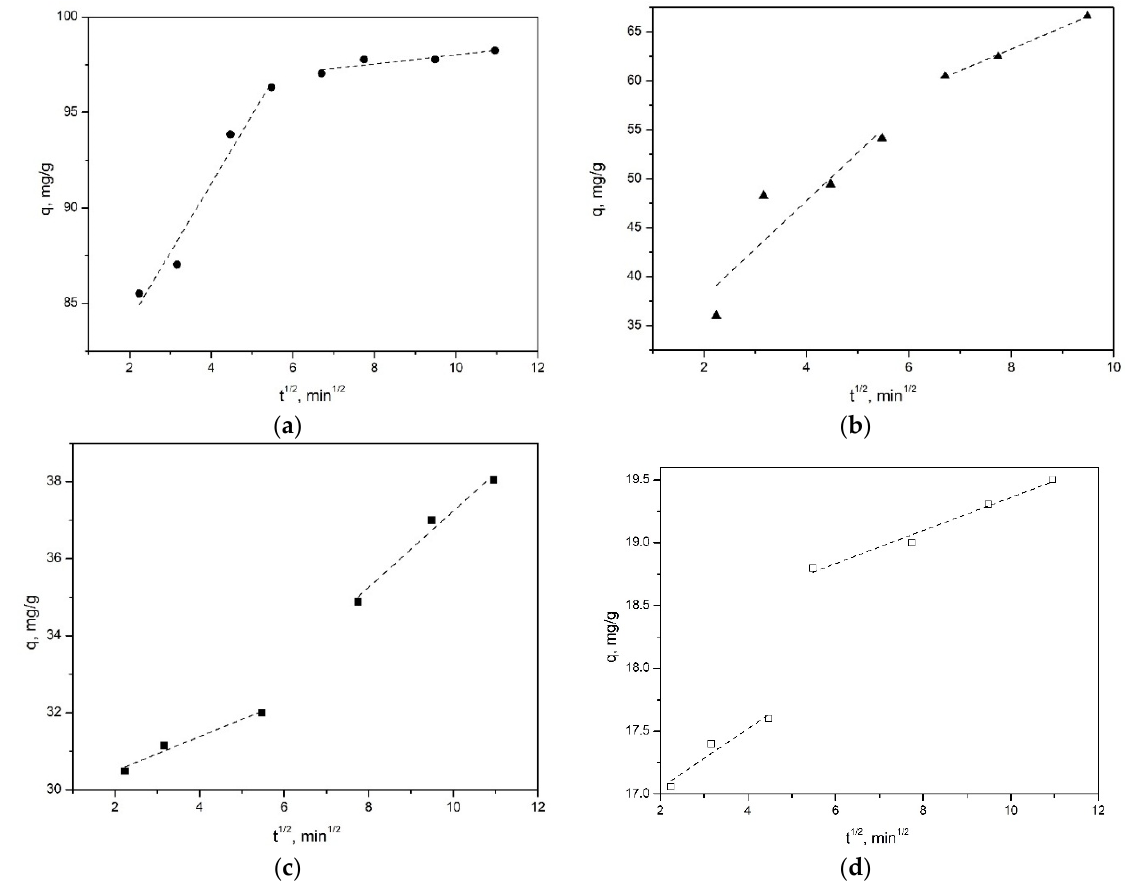
Figure 9. The dependence of q t on t during sorption of MB by the samples with different morphologies: ( a ) — spheres, ( b )—nanosponges, ( c ) — nanotubes, ( d ) — plates. Table 5. The parameters of sorption diffusion models of on the samples with different morphologies.